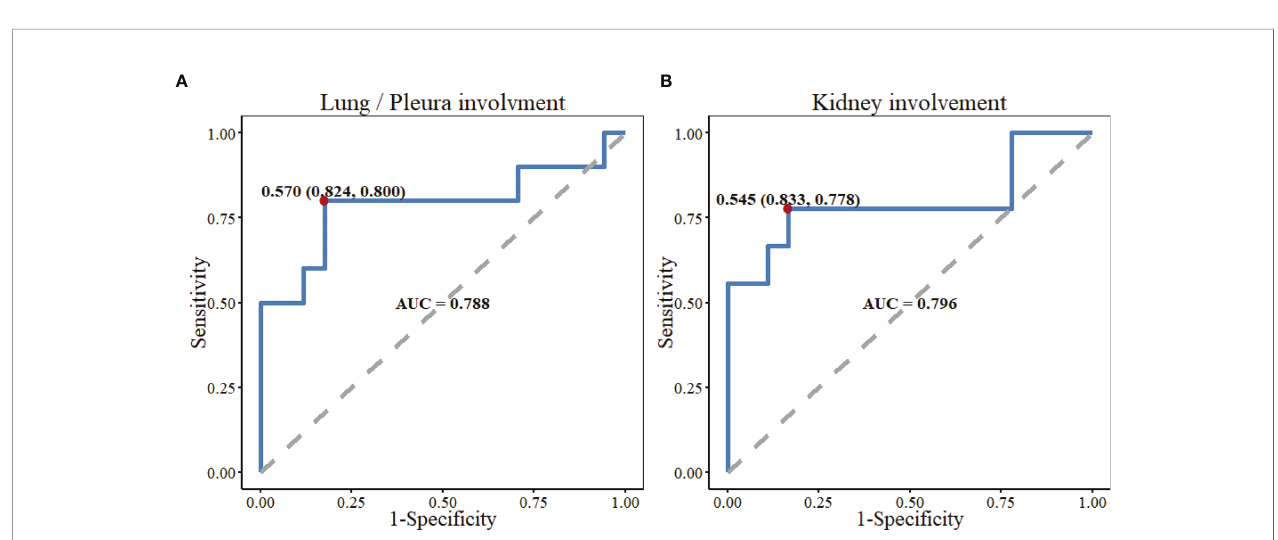
FIGURE 3 | The predictive performance of serum C3 level in lung/pleura and kidney involvement in patients with IgG4-RD. (A) ROC test indicated the possibility of lung/pleura involvement when C3 was less than 0.570 g/l (AUC=0.788, P=0.014). (B) There might be kidney involvement when C3 was less than 0.545 g/l (AUC=0.796, P=0.014). C3, Complement 3; ROC, receiver operator characteristic; AUC, area under the curve; Kidney involvement included kidney, renal pelvis, and ureter